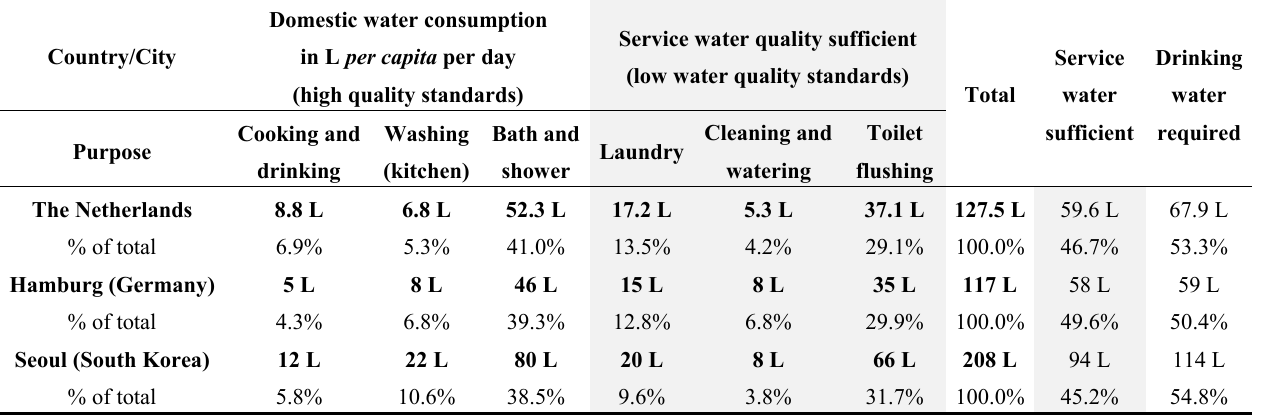
Table 1. Domestic water use for different applications in the Netherlands [11], Hamburg (Germany) [10], and Seoul (South Korea) [9], in L per capita per day, and percentages of total water